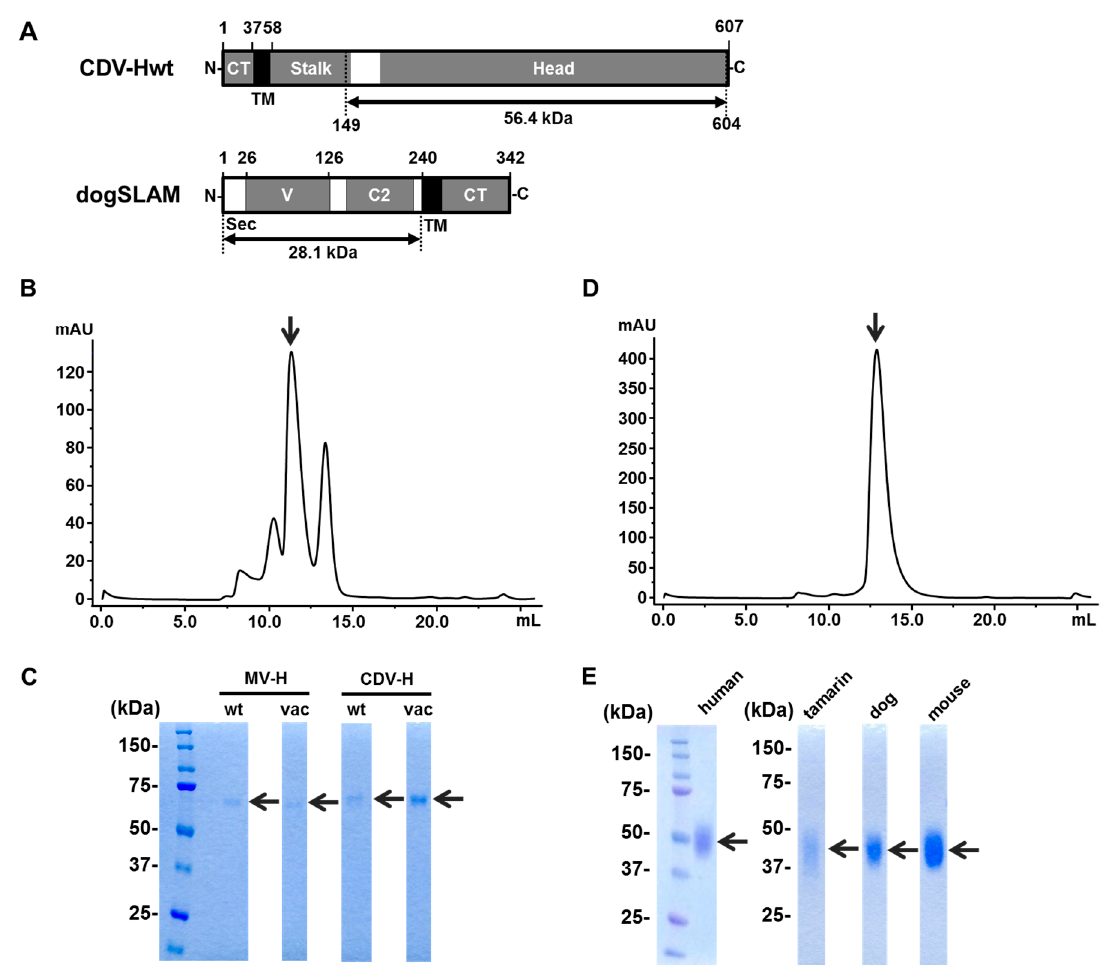
Figure 1. Expression and purification of canine distemper virus hemagglutinin (CDV-H) and dog signaling lymphocyte activation molecule (SLAM) proteins. ( A ) Schematic images for the domains of CDV-H (top) and dog SLAM (bottom). CT: Cytoplasmic tail, TM: Transmembrane domain, Head: Globular head domain, Sec: Secretary signal sequence, V: V-set domain. The arrows indicate the expression regions. ( B ) Gel filtration chromatograph of CDV-Hvac head domain. The arrow indicates the fraction of CDV-Hvac. ( C ) Sodium dodecyl sulfate polyacrylamide gel electrophoresis (SDS-PAGE) analysis of purified hemagglutinins (H) proteins (MV-Hwt, MV-Hvac, CDV-Hwt, and CDV-Hvac) in reduced condition. ( D ) Gel filtration chromatograph of dog SLAM. The arrow indicates the fraction containing soluble dog SLAM. ( E ) SDS-PAGE analysis of purified SLAM proteins (human, tamarin, dog, and mouse) in reduced condition. The arrows indicate the protein bands corresponding to each protein.